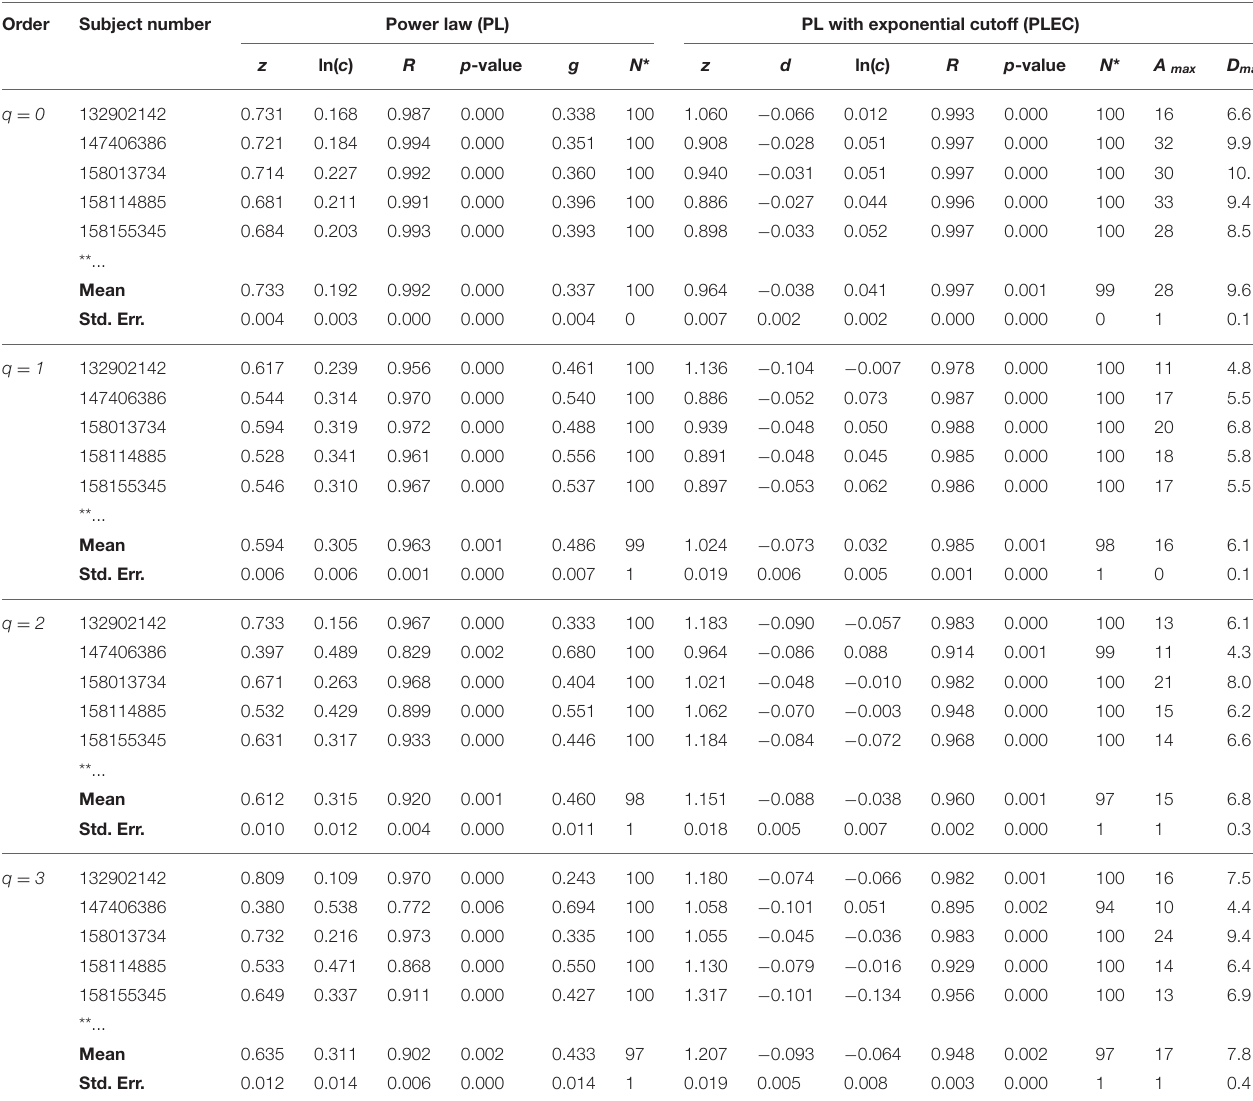
TABLE 2 | The intra-individual beta-DAR modeling for the HMP dataset (Demon version, Full version in Table S2 ). Order